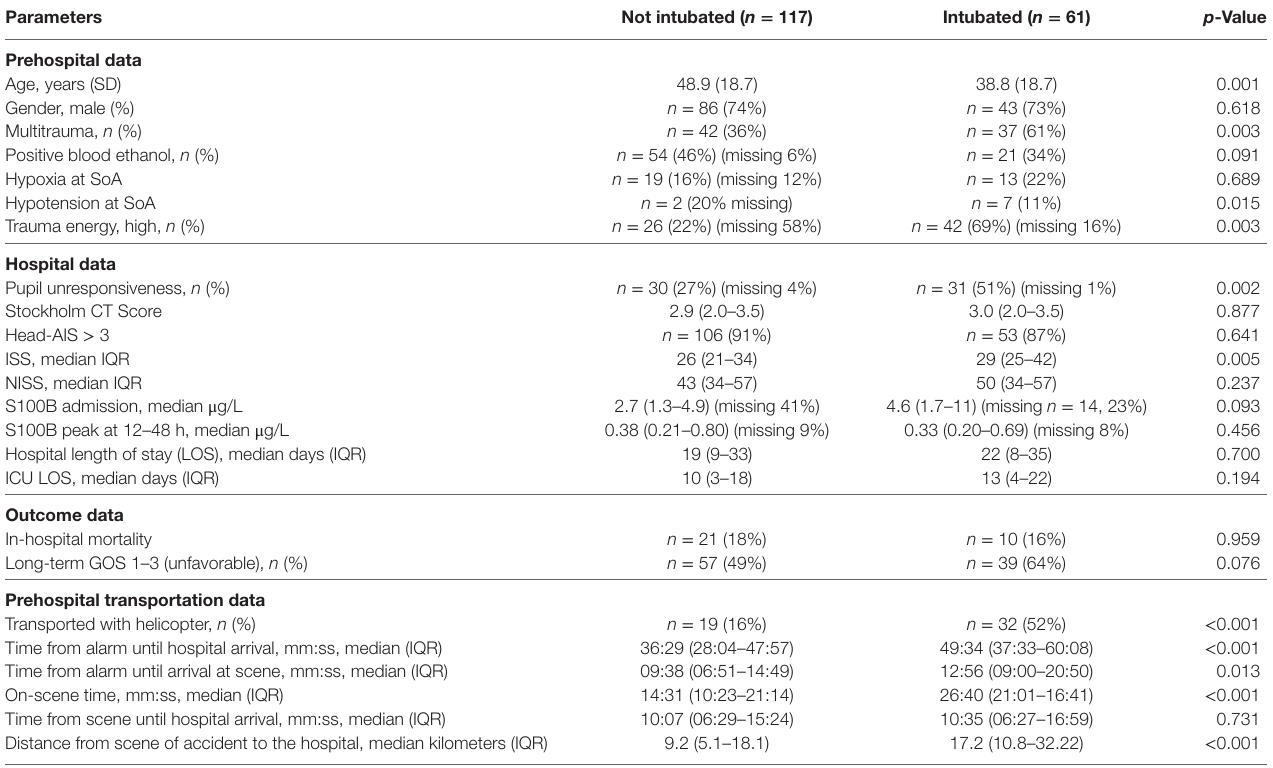
Table illustrating the demographic data between intubated and non-intubated patients. Missing data are mentioned for each parameter, if present. Difference between groups are compared using chi-square or Mann–Whitney test, were applicable. SoA, scene of accident; CT, computerized tomography; AIS, Abbreviated Injury Scale; ISS, Injury Severity Score; NISS, New Injury Severity Score; ICU, intensive care unit; GOS, Glasgow Outcome Score; IQR, interquartile range; mm, minutes; ss,